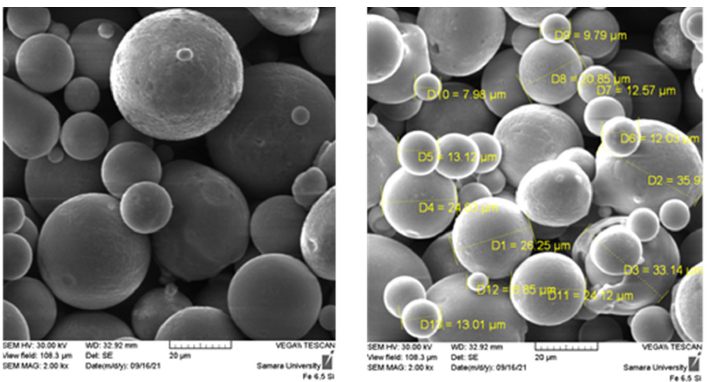
Figure 1. Particles of Fe–6.5Si magnetic steel powder.